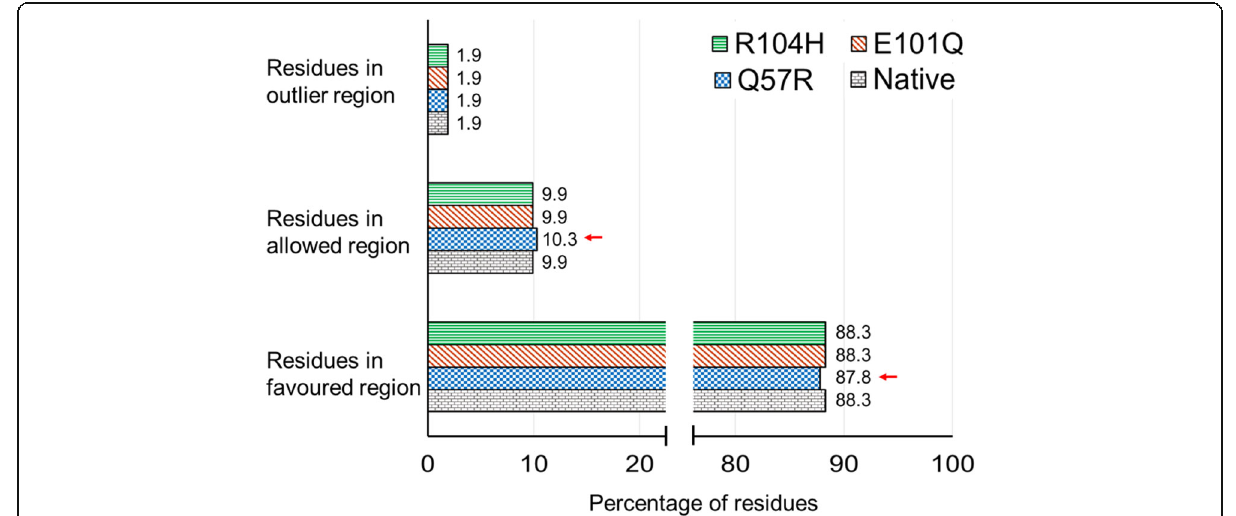
Fig. 6 Residue profiling of native and mutated connexin 30 calculated by